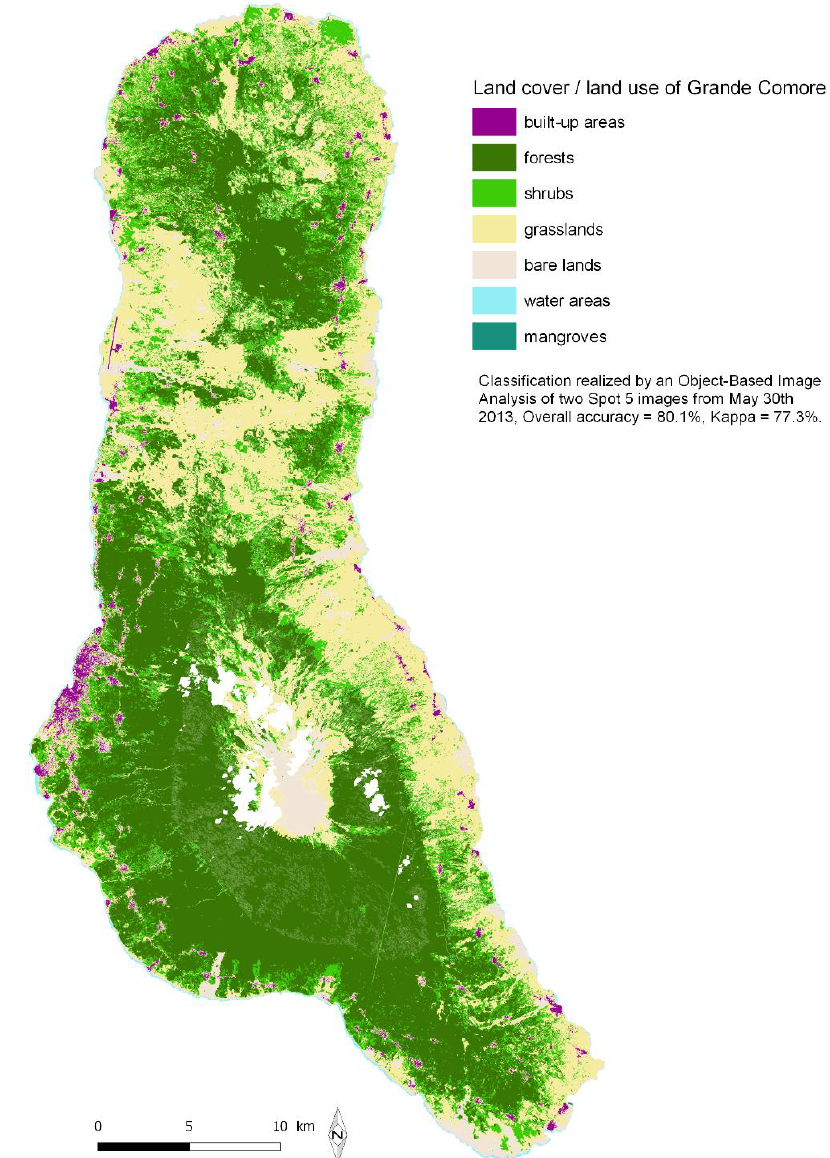
Figure 5. Land cover/land use map of Grande Comore.